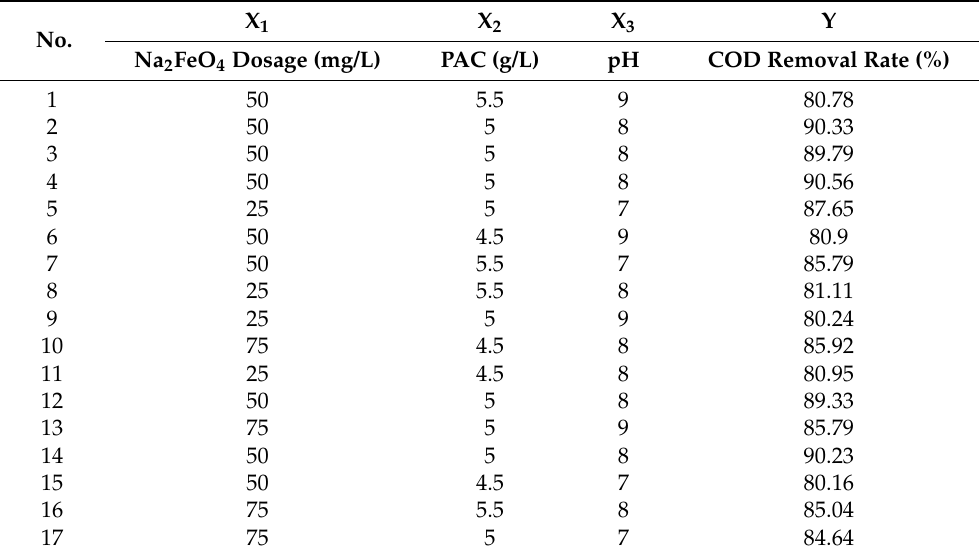
Table 2. Experimental design and obtained results.